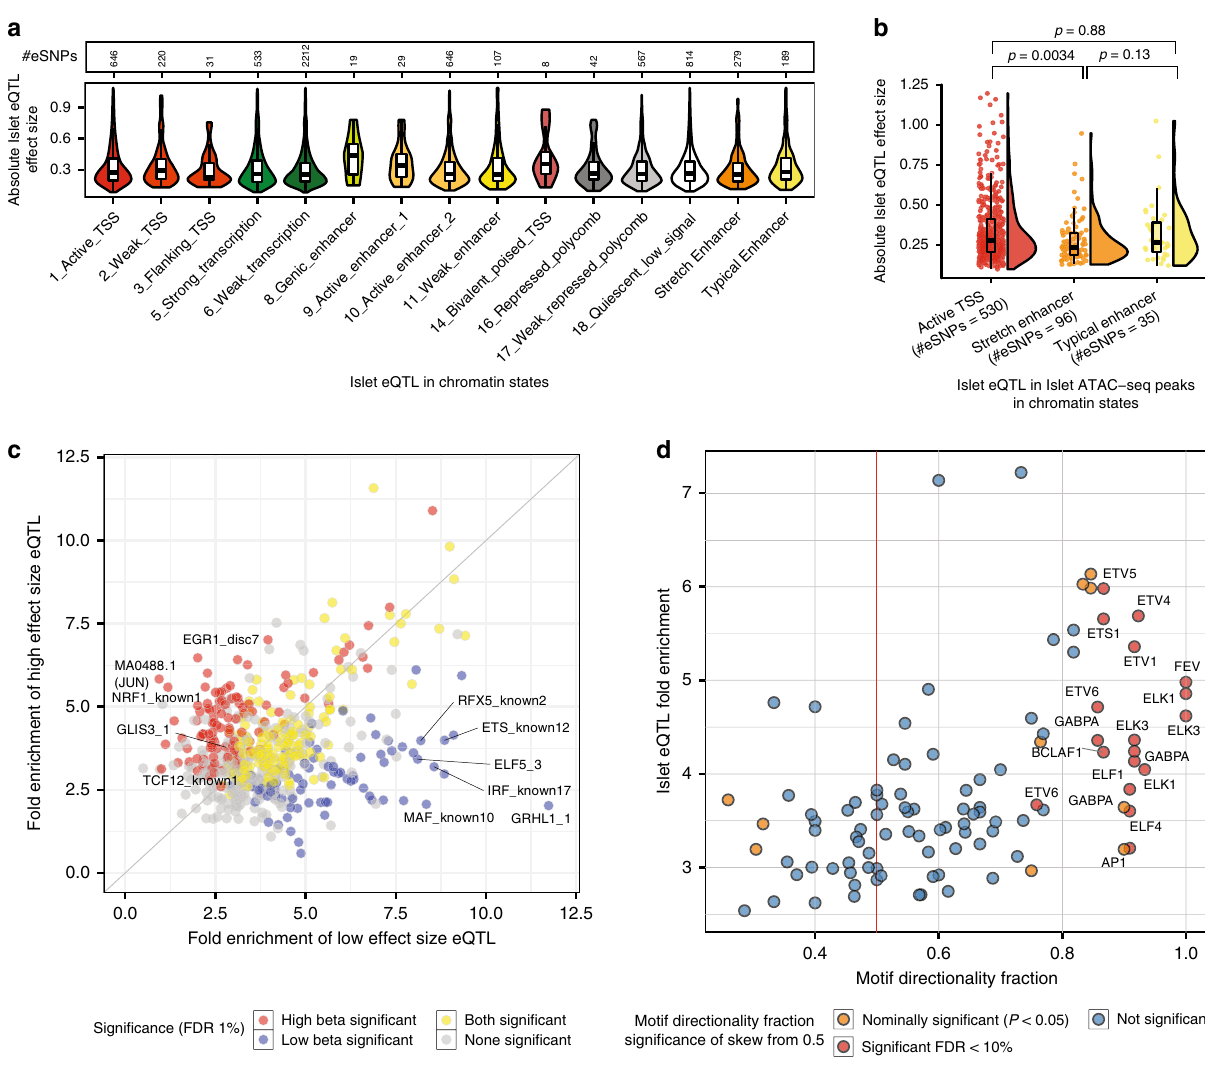
Motif directionality fraction significance of skew from 0.5 Fig. 2 Integration of islet eQTL with epigenomic information. a Distribution of absolute effect sizes for islet eQTLs in each islet chromatin state. b Distribution of absolute effect sizes for islet eQTL in ATAC-seq peaks in three islet chromatin states. eQTL SNPs in ATAC-seq peaks in stretch enhancers have signi fi cantly lower effect sizes than SNPs in ATAC-seq peaks in active TSS and typical enhancer states. P -values were obtained from a Wilcoxon rank- sum test. c Fold enrichment for transcription factor footprint motifs to overlap low vs high effect size islet eQTL SNPs. d TF footprint motif directionality fraction vs fold enrichment for the TF footprint motif to overlap islet eQTLs. TF footprint motif directionality fraction is calculated as the fraction of eQTL SNPs overlapping a TF footprint motif, where the base preferred in the motif is associated with increased expression of the eQTL eGene. Signi fi cance of skew of this fraction from a null expectation of 0.5 was calculated using the binomial test. Source data are provided as a Source data fi